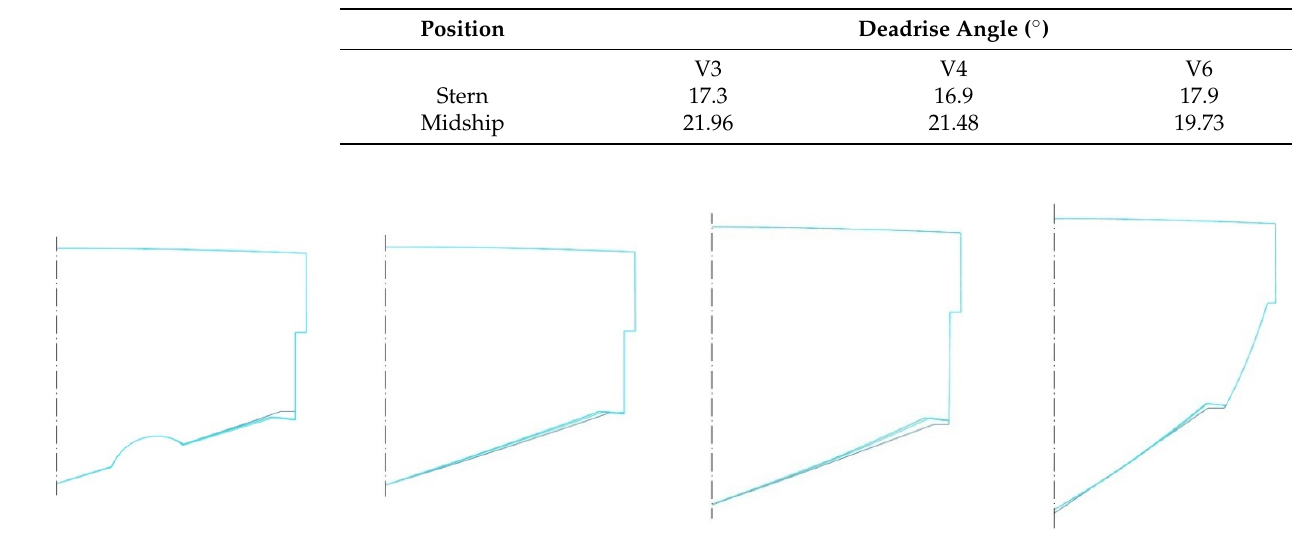
Table 9. Lift computed on tunnel surface.